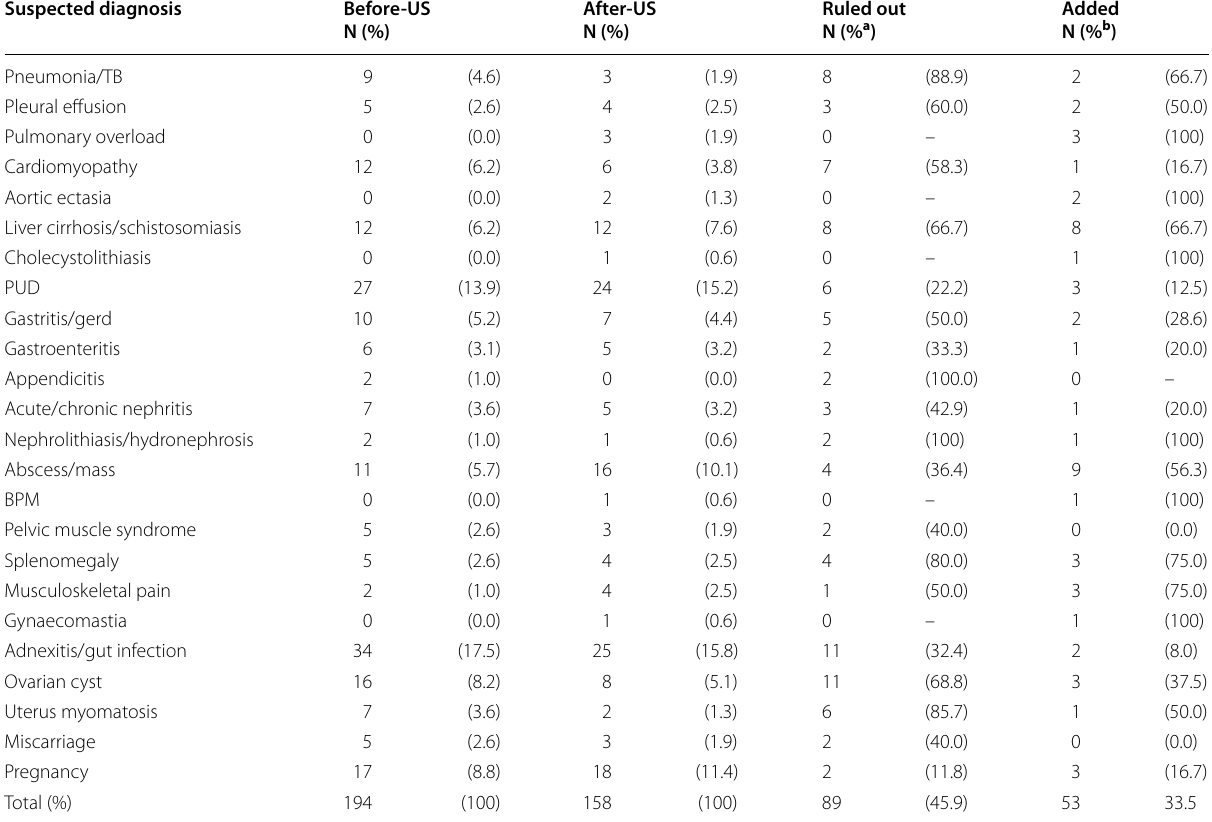
Table 4 Suspected diagnosis in the sample